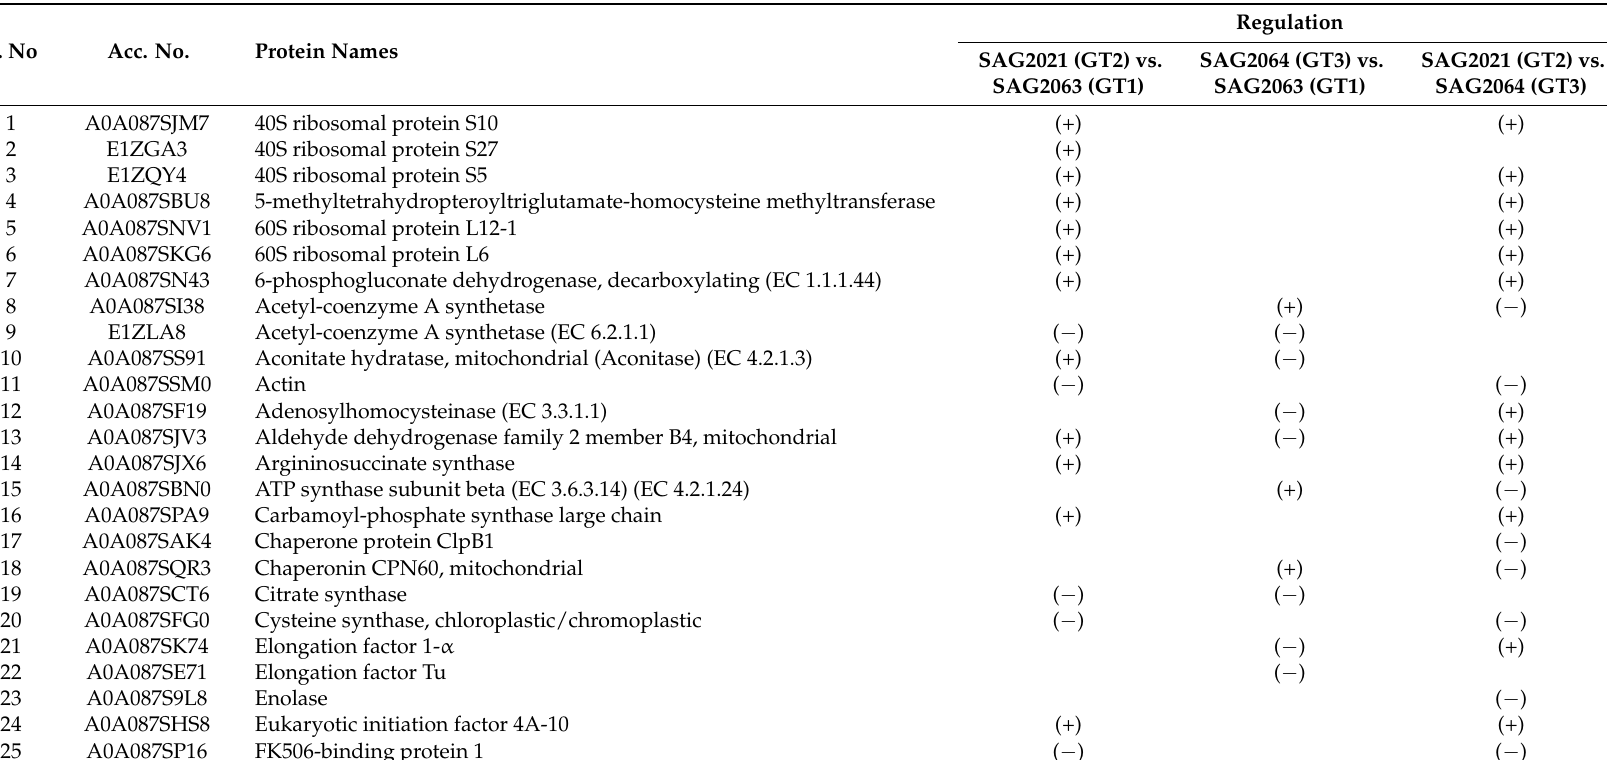
Table 1. List of the differentially expressed proteins: S. No: serial number as number assigned α -betically to entry. Acc. No. is the accession number and proteins names are as listed in the Uniprot Knowledgebase database. Regulation: only those proteins which are significantly regulated and after filtering 1% false discovery rate (FDR). (+) indicates upregulated and ( − ) indicates downregulated.